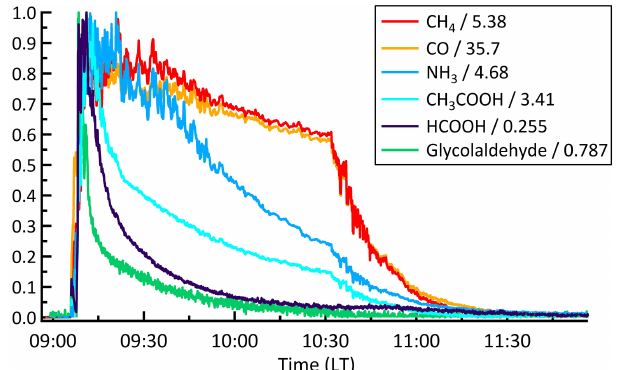
Figure 3. Excess mixing ratios of sticky and non-sticky gases nor- malized by their maximum mixing ratio (shown in legend) to have a maximum value of one during a “room” burn of organic hay. The stable non-sticky species shown are CO and CH 4 , while the stickier species include HCl, NH 3 , glycolaldehyde, CH 3 COOH, and HCOOH; the latter show a faster rate of decay than the stable species CO and CH 4 .